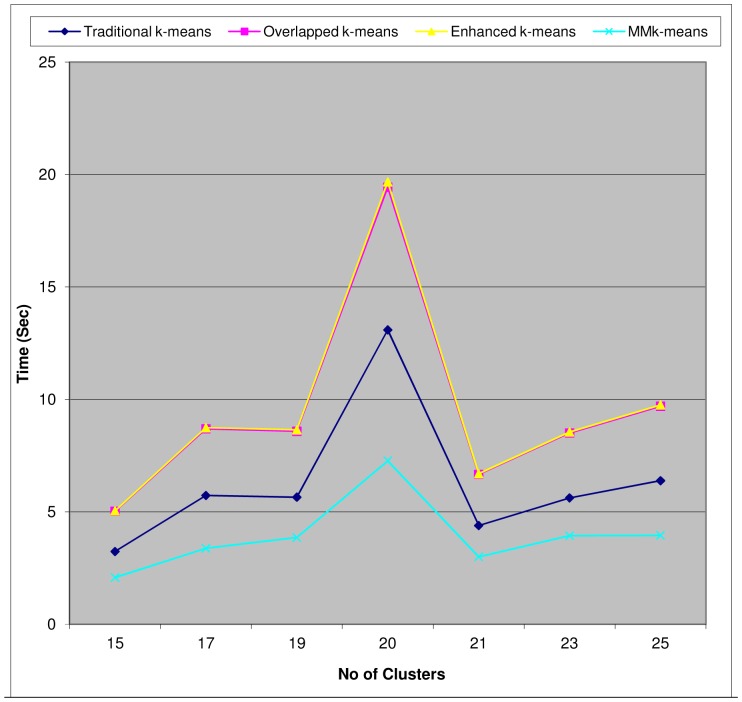
Execution Time (Bozdech et al., P.f 3D7 Microarray Dataset).The plot shows that our MMk-means has the fastest run-time for tested number of clusters, 15≤k≤25. Comparatively, k = 20 took the longest run-time for all the four algorithms, implying that this is a function of the nature of the data under consideration.